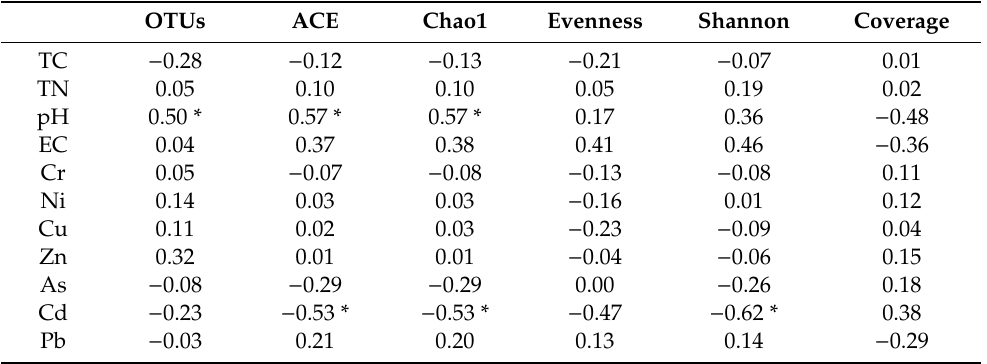
Table 3. Pearson correlation analysis between bacterial diversity and environmental variables 1 . OTUs